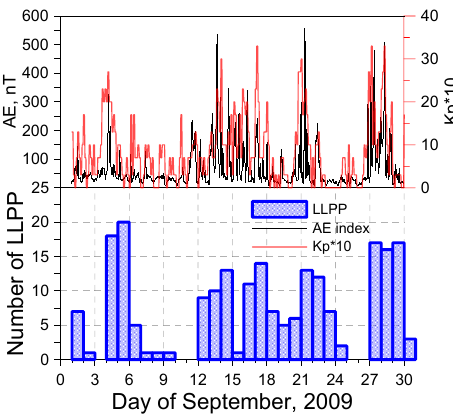
Figure 6. Magnetic activity and LLPP daily occurrence in Septem- ber 2009 according to NOAA-19 observations. Table 1. Occurrence of latitudinal shifts of the 30keV and 80keV